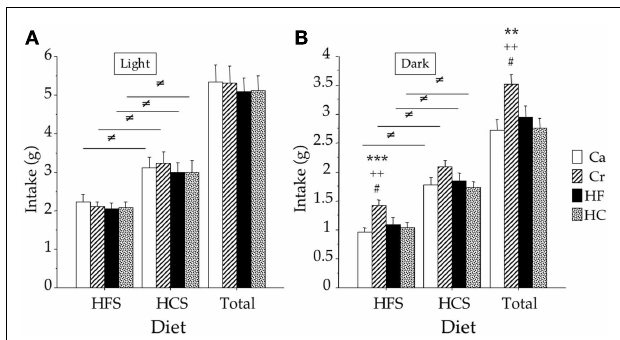
FIGURE 4 | Intakes (mean ± SEM in grams) of high-fat (HFS) and high-carbohydrate (HCS) isocaloric solutions during dietary preference tests performed during light (A) and dark (B) periods in offspring from dams fed during gestation either a control diet (Ca group) ad libitum , or a restricted control (Cr group), a high-fat (HF group) or a high-carbohydrate (HC group) diet ad libitum for 6h during the light period, in addition to two normal meals given during the dark period. (cid:54)= p < 0.001 between HF and HC intakes for the same group; ** p < 0.01, and *** p < 0.001 vs Ca; # p < 0.05 vs HF; ++ p < 0.01 vs